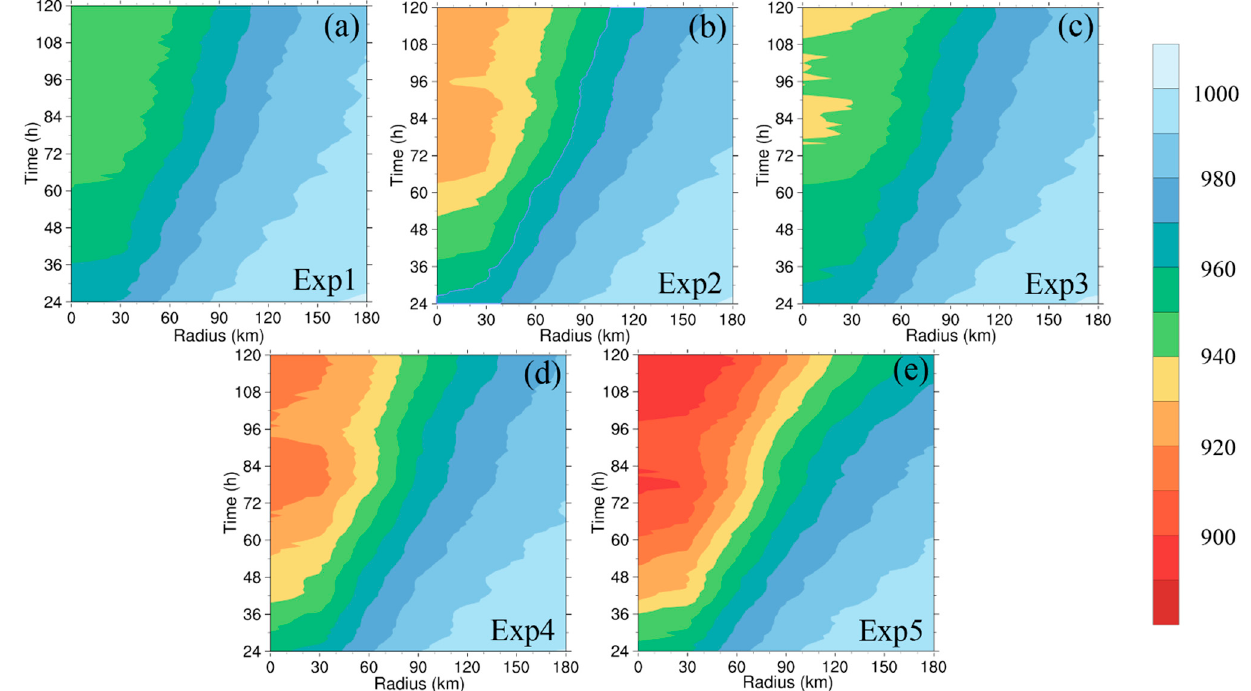
Figure 12. Hovmöller diagrams of the SLP as simulated by the five experiments ( a – e ). The abscissa is the radial distance from the center of the TC, and the ordinate is the simulation time.